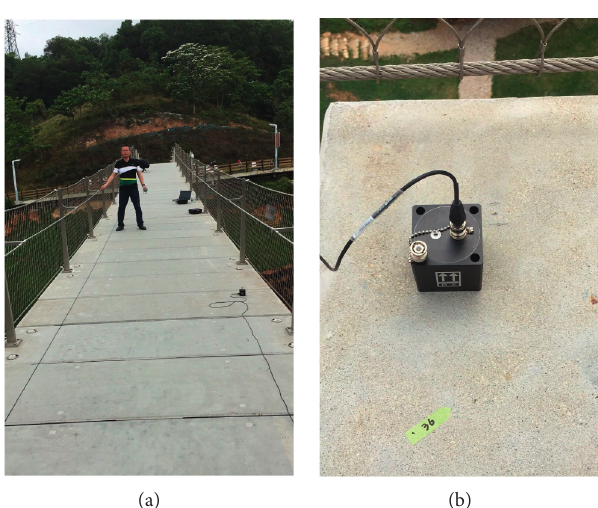
Figure 3: Photographs of the modal test. (a) Test scenario and (b) accelerometer.